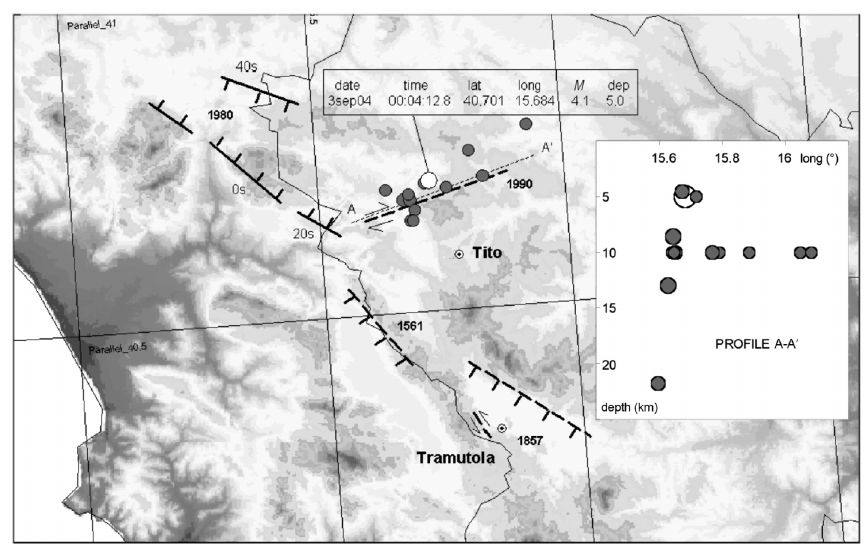
Fig. 3. Seismic sequence occurred on September 3-4, 2004, and hypocentres of the earthquakes along the pro- file A-A l on Potenza strike-slip fault. The map shows the normal fault system of Irpinia earthquake 1980 with the main subevents indicated as 0 s, 20 s and 40 s. The solid lines represent the fault fragments activated in the investigated area which are mainly constrained by surface and levelling data. The dashed lines indicates the probably position of the faults and their